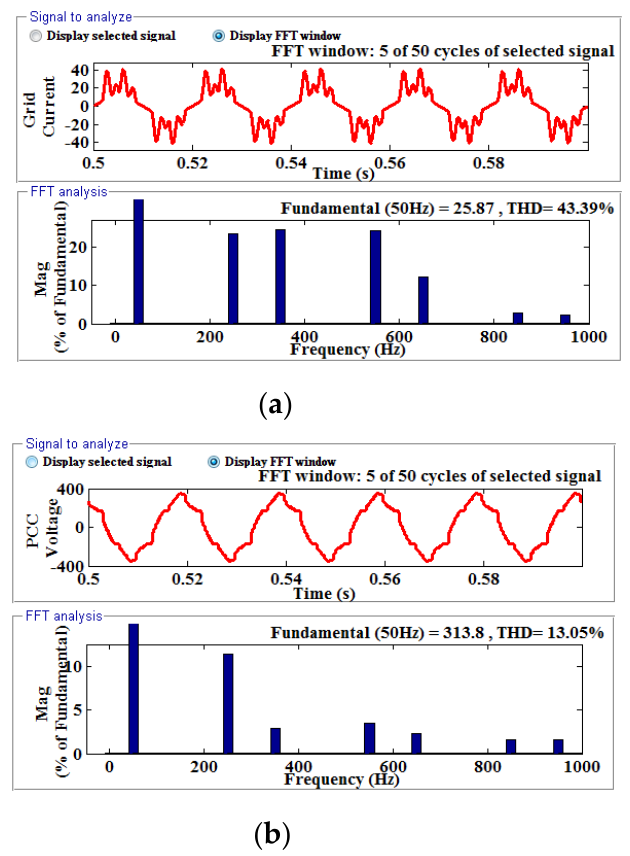
Figure 6. ( a ) FFT analysis of distorted load current/grid current with a capacitive load, and ( b ) FFT analysis of PCC voltage with capacitive load.